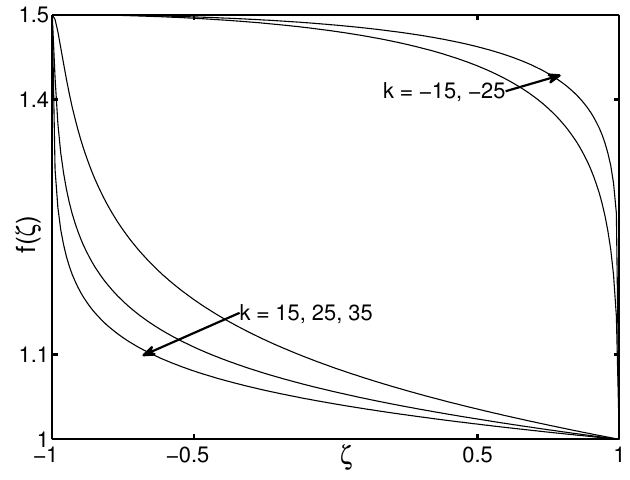
Figure 2. The graph of f ( ξ ) given by Equation (24) as k approaching − ∞ and + ∞ .